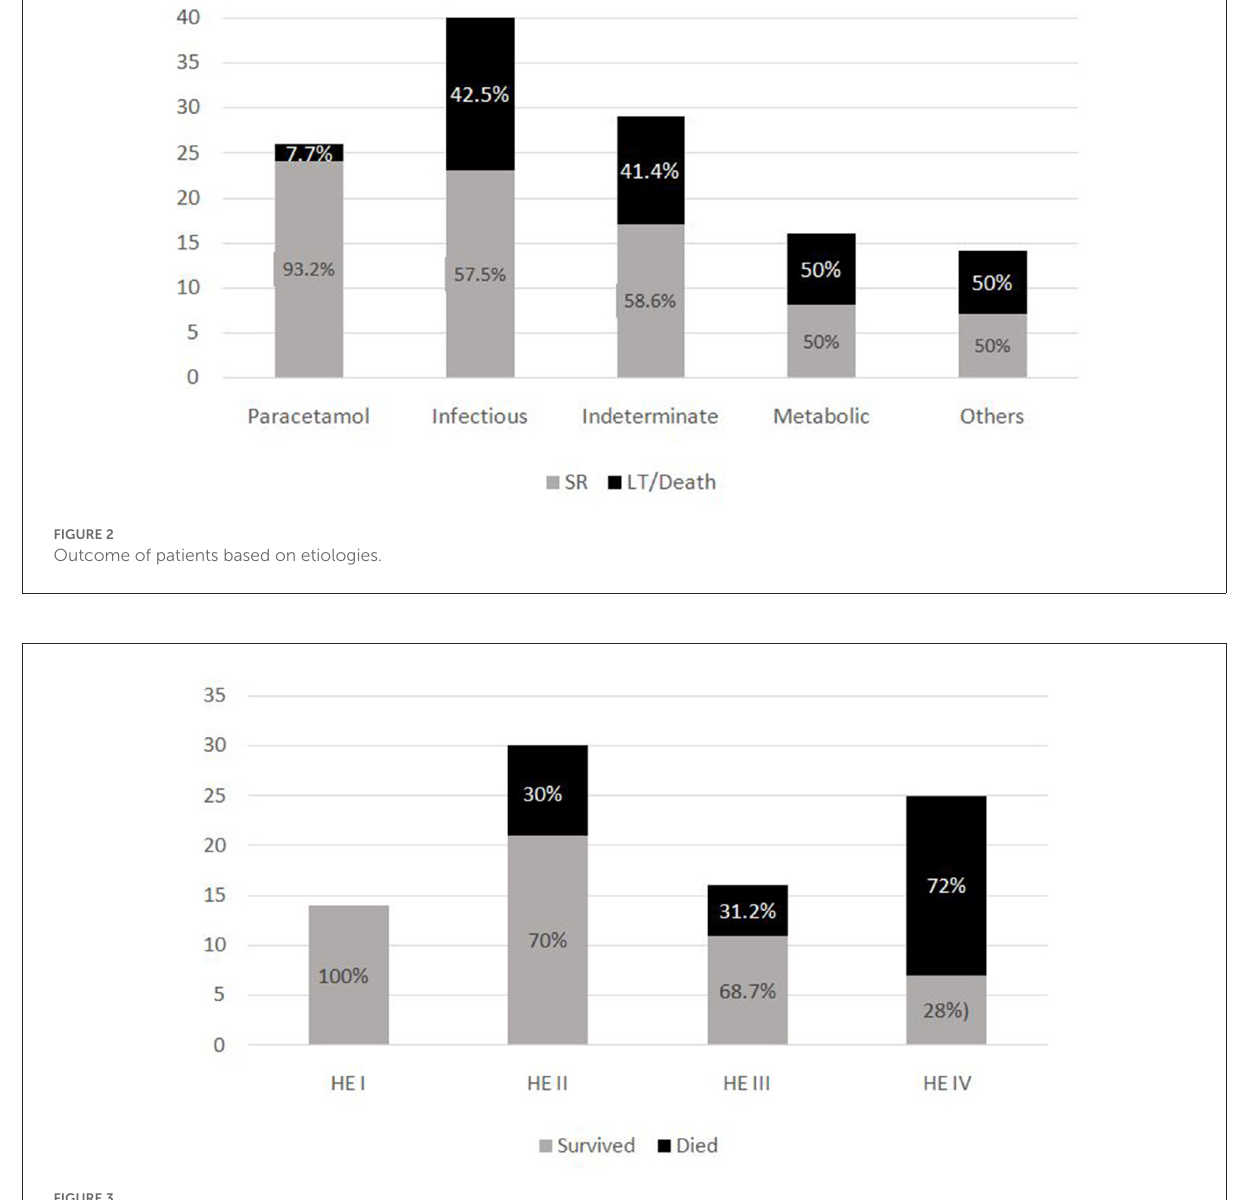
direct bilirubin when compared to SR group, as shown in Interventions During the PICU stay, 54.4% needed inotropes, 62.4% were invasively ventilated, and 28.8% patients underwent RRT. In our